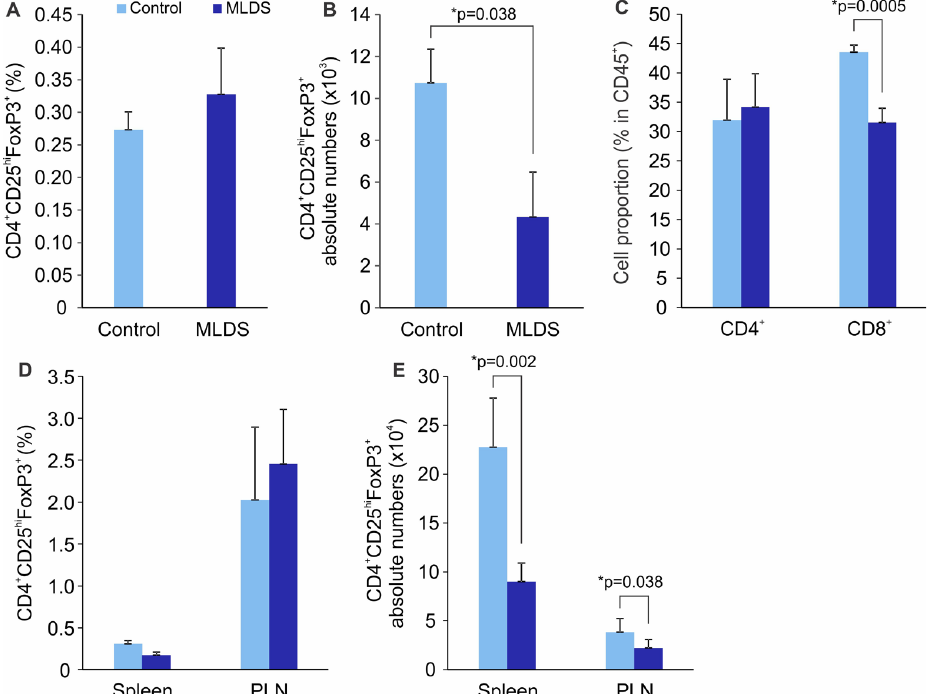
Figure 5. Diabetic C57BL/6 mice have lower numbers of Treg in the SILP and spleen. The percentages of CD4 + CD25 hi FoxP3 + Treg ( A ) and their absolute numbers ( B ) in the SILP of normoglycemic healthy mice (control) and hyperglycemic C57BL/6 mice (MLDS). Frequencies of CD4 + and CD8 + T cells in the SILP ( C ). Treg proportions in the spleen and pancreatic lymph nodes (PLN) ( D ) and their absolute numbers ( E ). Number of mice per group was 5. * p < 0.05 was considered as statistically significant when samples from healthy and hyperglycemic mice were compared.